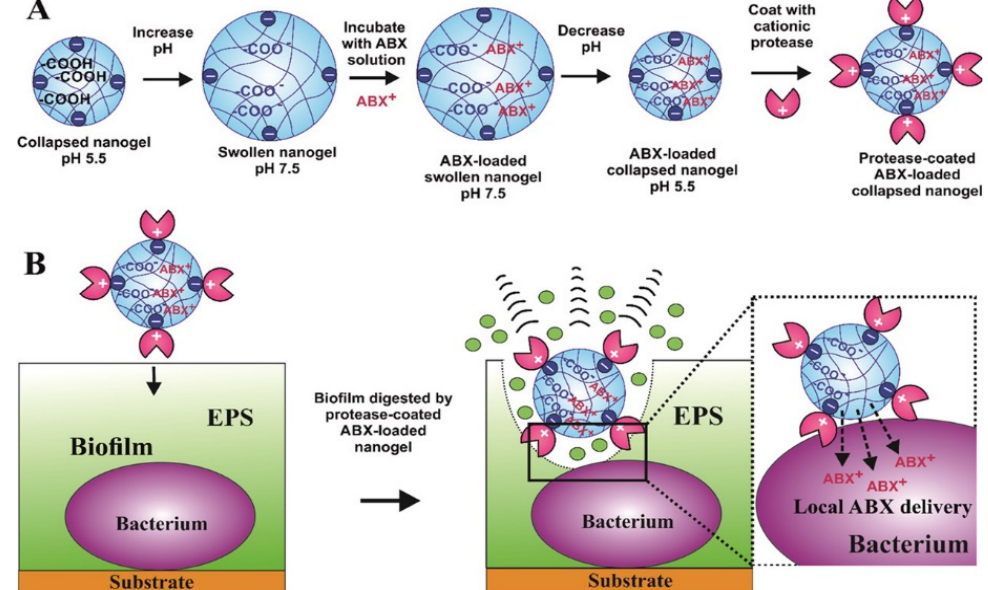
Figure 5. ( A ) The schematic diagram for the loading of the Carbopol Aqua SF1 NG with an antibiotic (ABX + ) (ABX = ciprofloxacin) followed by surface coating with protease (Alcalase 2.4 L FG). ( B ) Diagram of the mechanism of action of the Carbopol Aqua SF1–Alcalase 2.4 L FG NG particles on biofilms adhered to a substrate. Reproduced from Weldrick et al. [165] with permission from Amer- ican Chemical Society, USA.